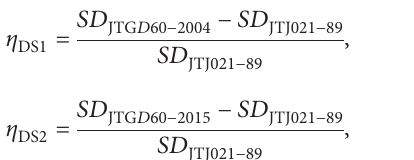
S1 ; (b) η S2 ; (c) η S3